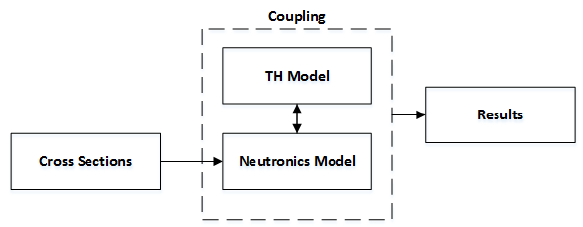
Figure 3. Calculation Process.